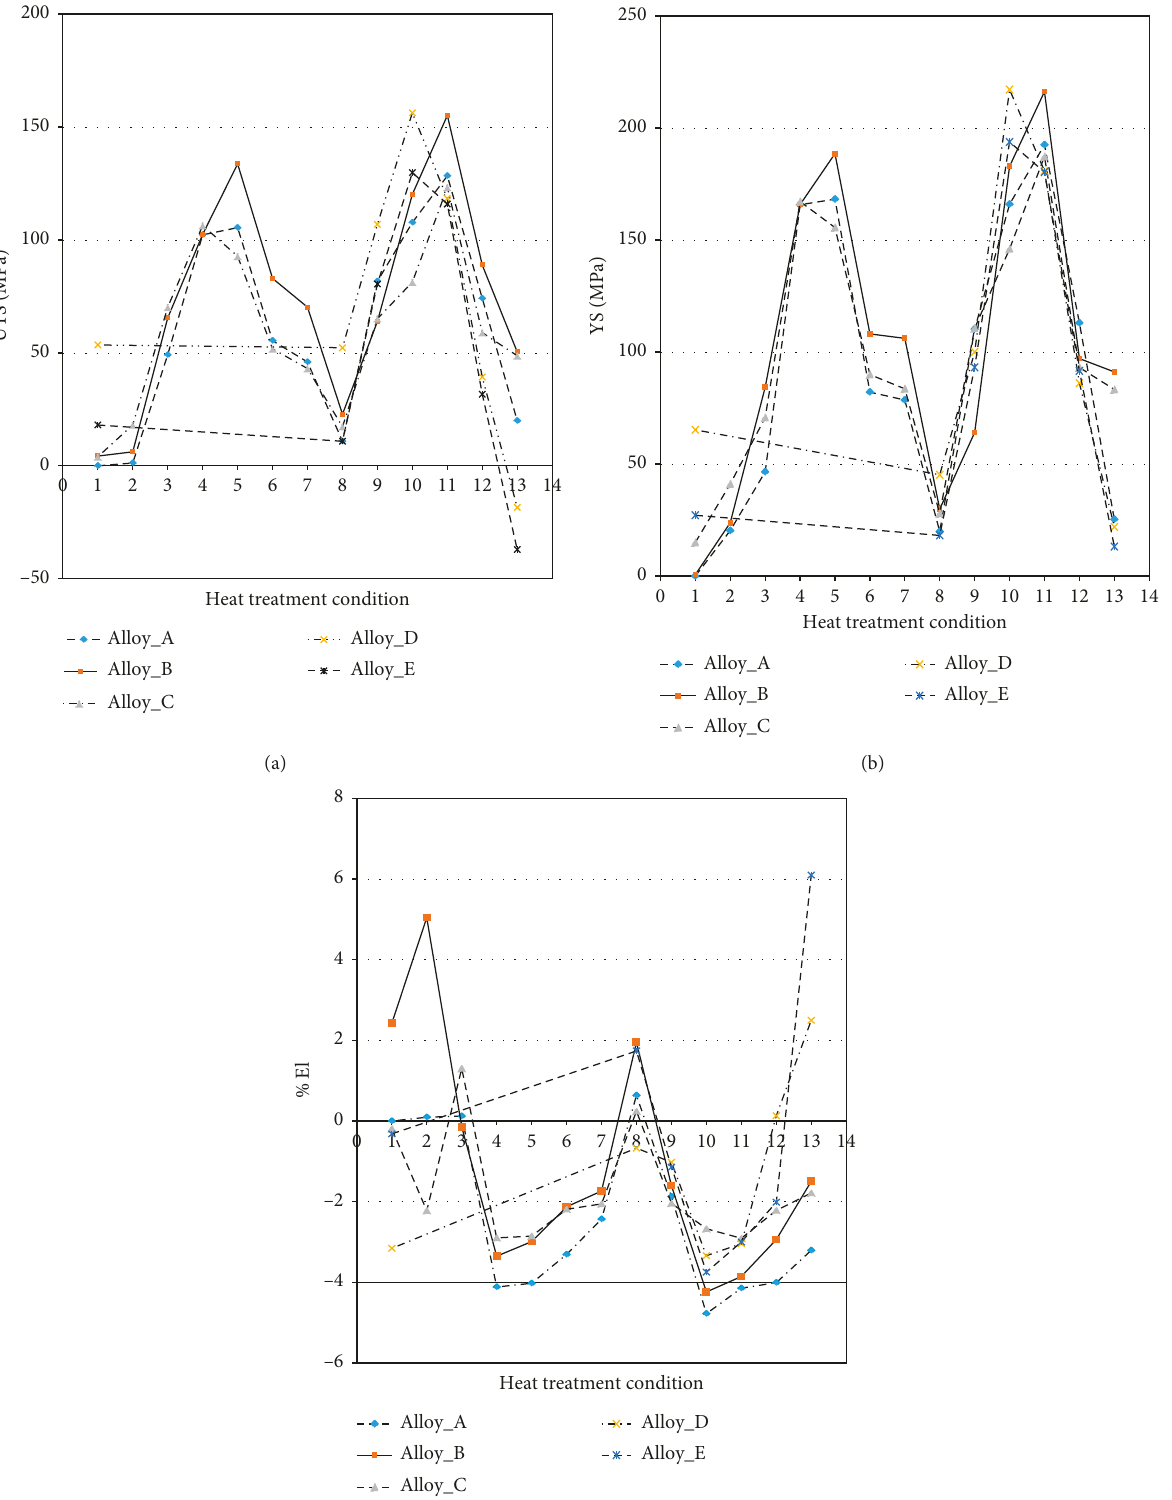
Figure 15: Comparison of tensile properties of A, B, C, D, and E alloys relative to those of as-cast base alloy A (a) ∆ P-UTS, (b) ∆ P-YS, and (c) ∆ P-%El as a function of heat-treatment conditions with SHT for 4h and